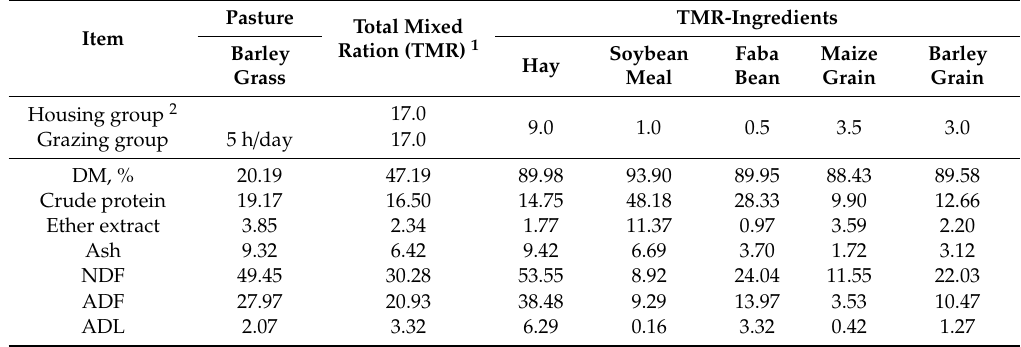
Table 1. Composition of diets as fed basis (kg / day per head) and chemical composition (% DM) of barley grass selected at pasture and feed o ff ered to the experimental